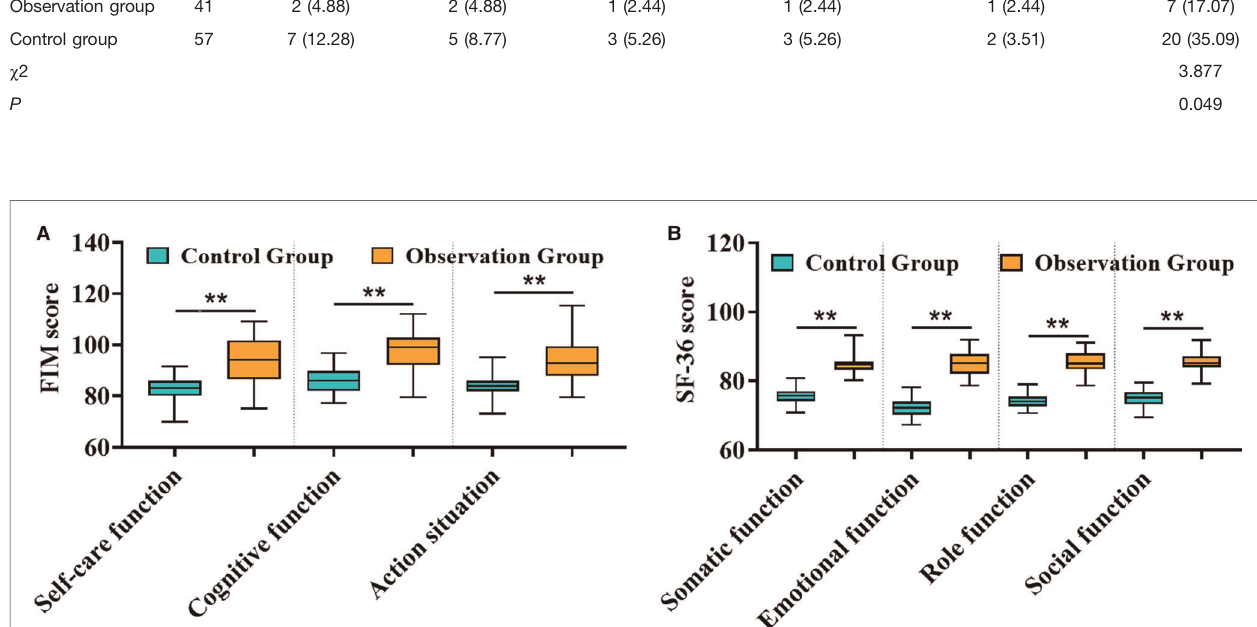
FIGURE 4 | Comparison of rehabilitation between both groups. ( A ) FIM score. ( B ) SF-36 score. ** P